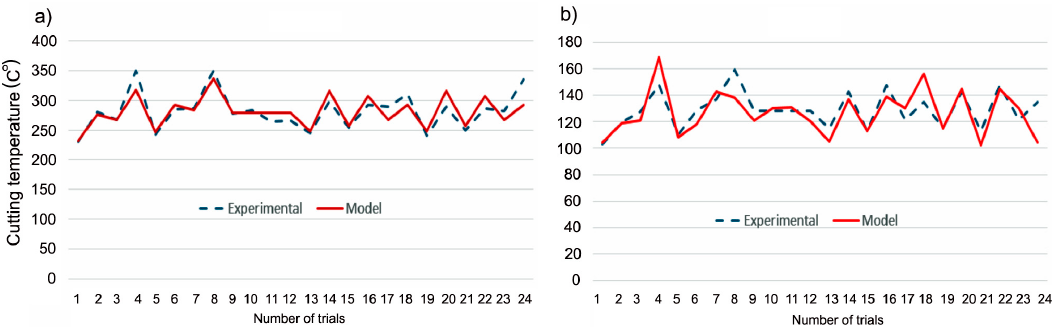
Figure 5. Correlation between experimental and model values of cutting temperature for tools: ( a ) HM and ( b ) CBN.